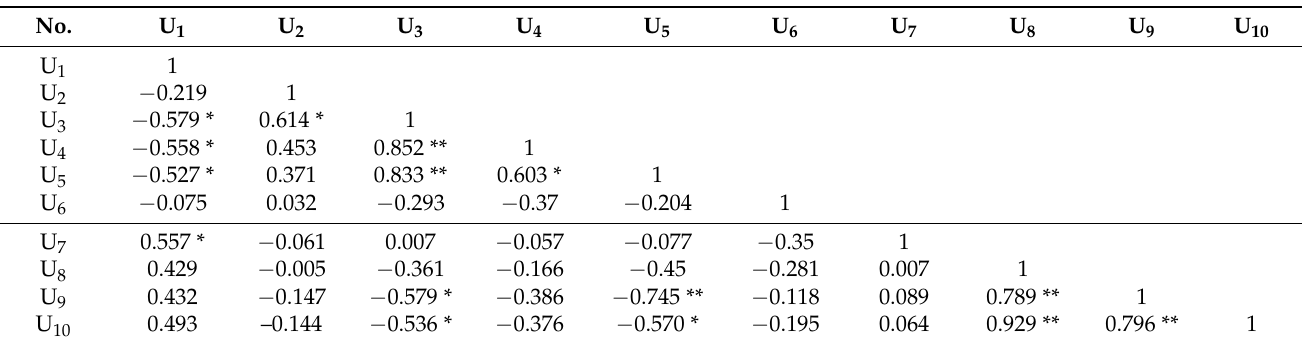
Table 5. Spearman’s correlation between indicators.